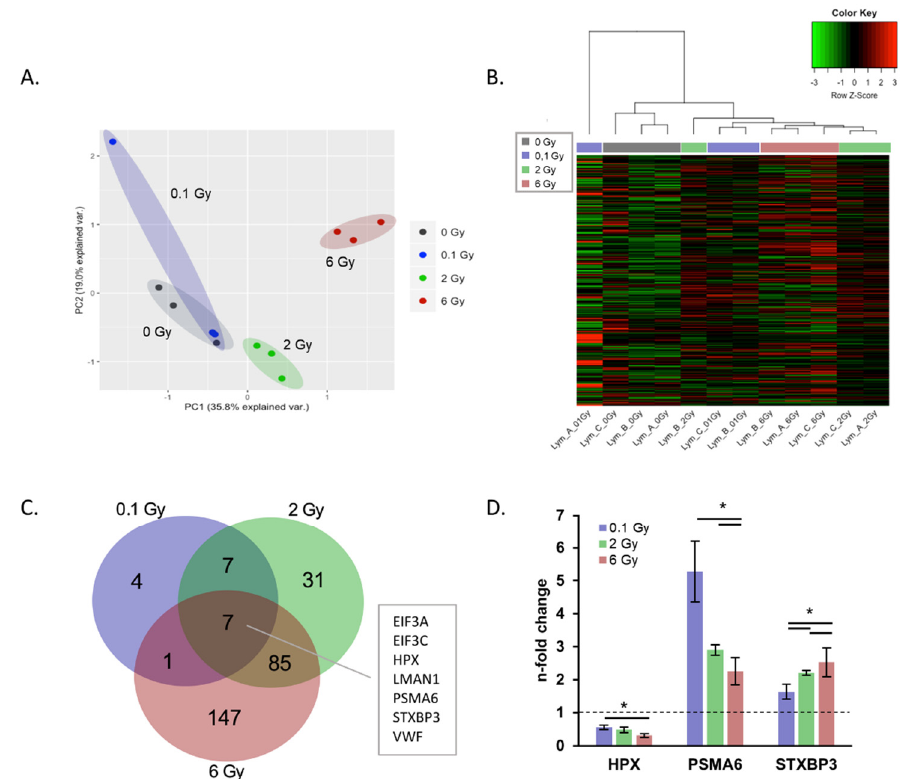
Figure 3. Protein cargo of extracellular vesicles (EVs) derived from peripheral blood mononuclear cells (PBMCs) after irradiation. ( A ) Principle component analysis of radiation e ff ects on the EV proteome based on normalized abundancies of all identified proteins. ( B ) Hierarchical cluster analysis of EV protein expressions in samples from irradiated and non-irradiated donors. ( C ) Venn diagram showing the number of total and shared significantly proteins deregulated after irradiation. ( D ) n-fold changes of dose-dependent regulated EV proteins hemopexin (HPX), proteasome subunit alpha type-6 (PSMA6) and syntaxin-binding protein (STXBP3). * p ≤ 0.05 (calculated by two-sided Student’s t-test).